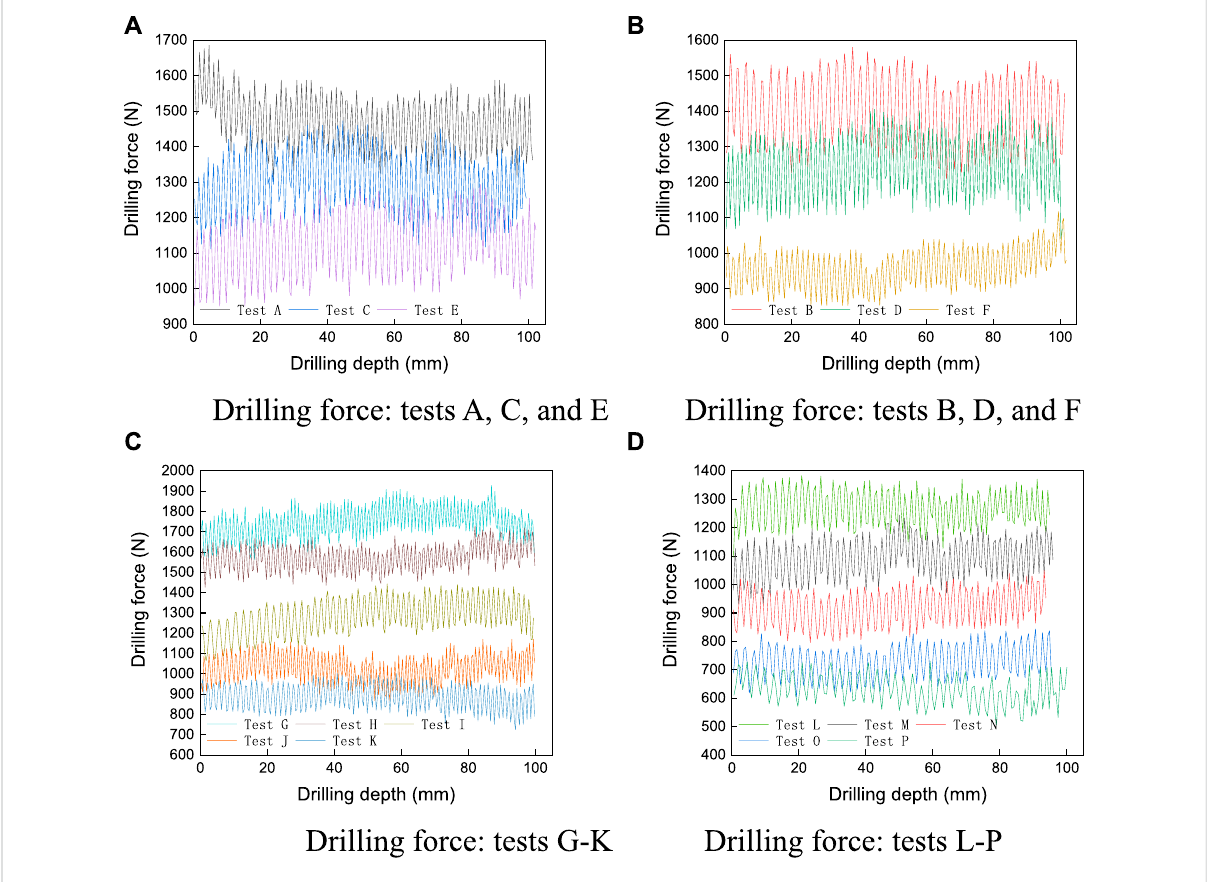
FIGURE 9 Drilling force v . drilling depth. (A) Drilling force: tests A,C,and E (B) Drilling force:tests B, D, andF. (C) Drillingforce: tests G – K (D) Drilling force: tests L –